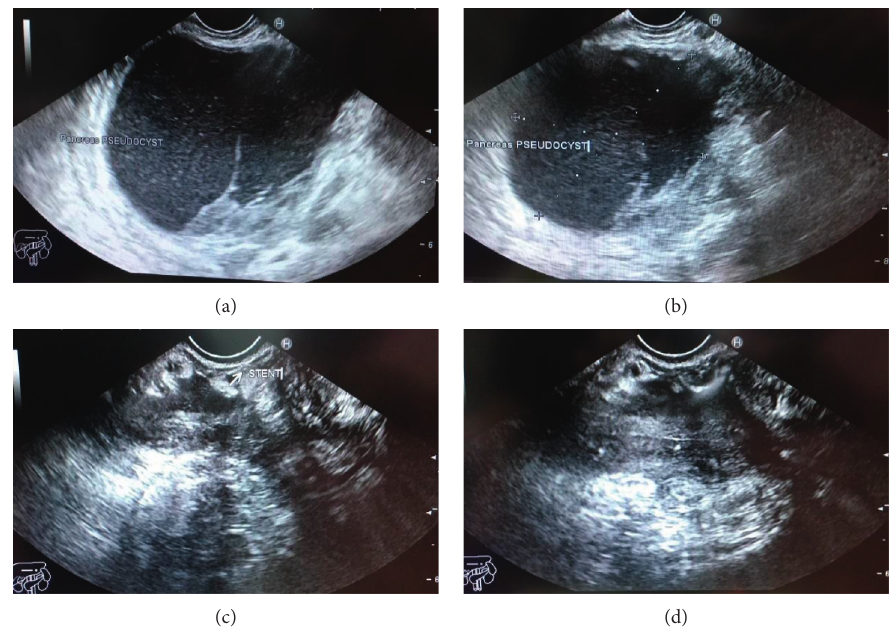
Figure 6: EUS image showing (a, b) a pancreatic pseudocyst before drainage and (c, d) the stent and pseudocyst after drainage.